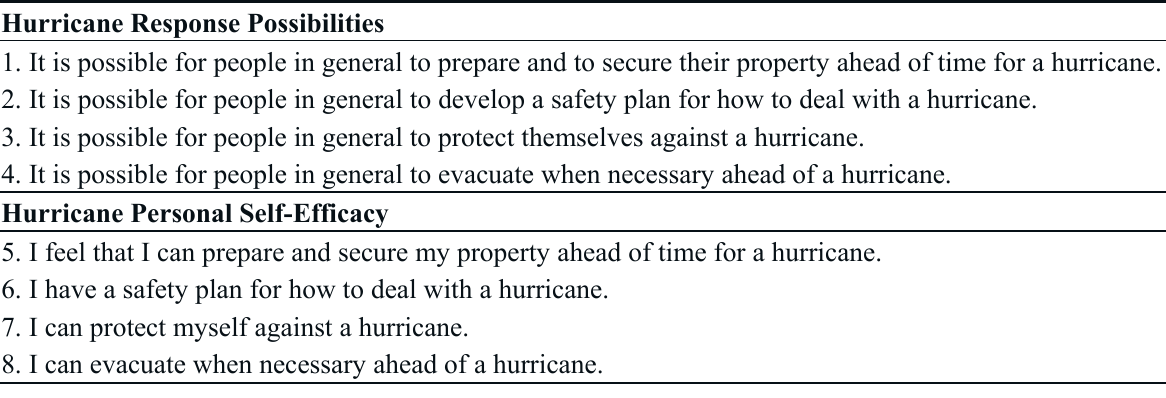
Table 1. Items in the Hurricane Personal Self-Efficacy Scale